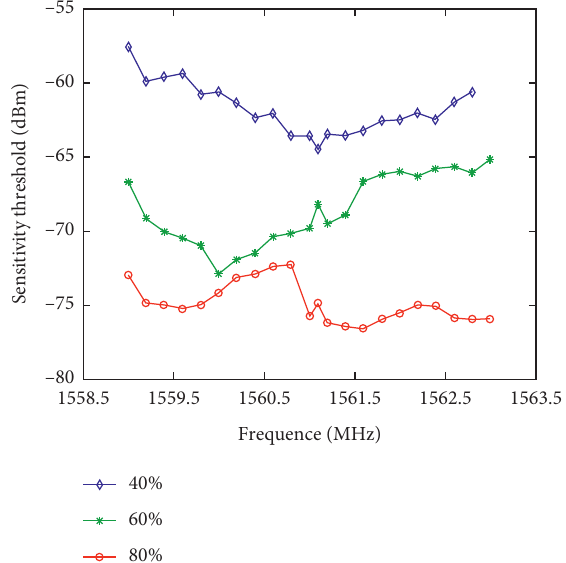
Figure 10: The electromagnetic sensitivity curve of the receiver when f PRF � 1kHz.